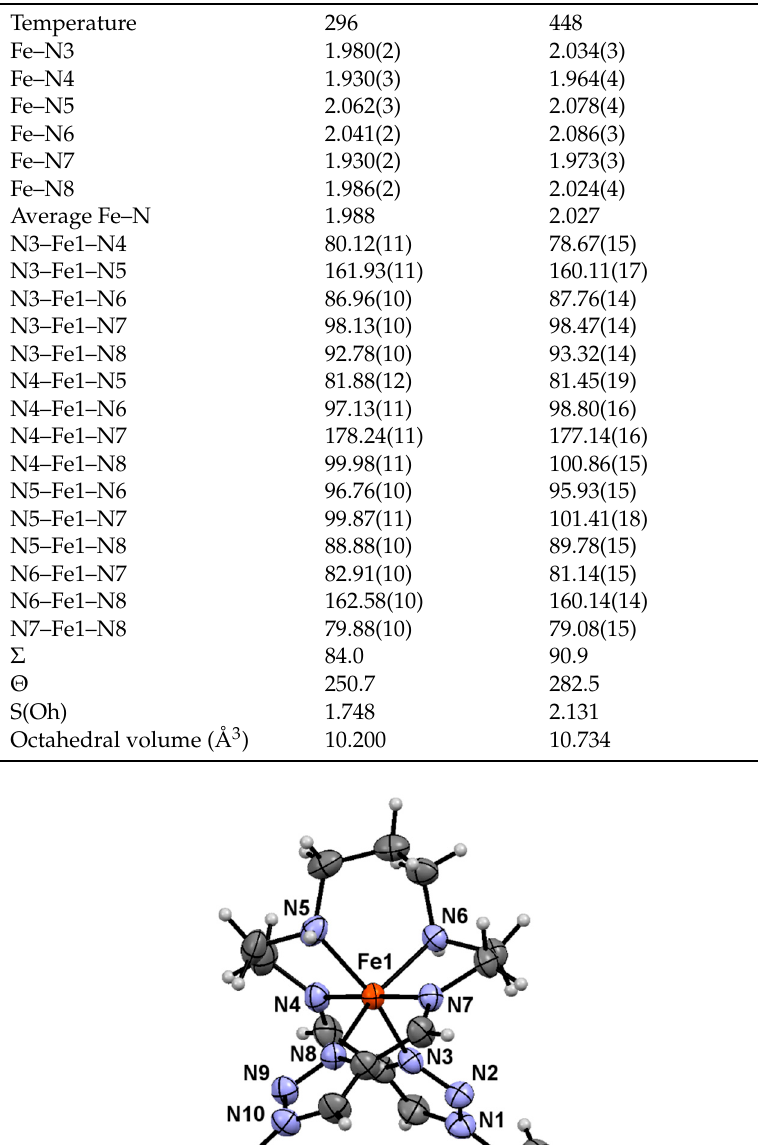
Table 2. Relevant coordination bond lengths (Å), angles ( ◦ ), and structural parameters for 1 . Σ [59] and Θ [60] are angular indices characteristic for the spin state of the complex. S(Oh) is the continuous shape measures (CShMs) of the Fe II centers relative to the ideal octahedron [61].